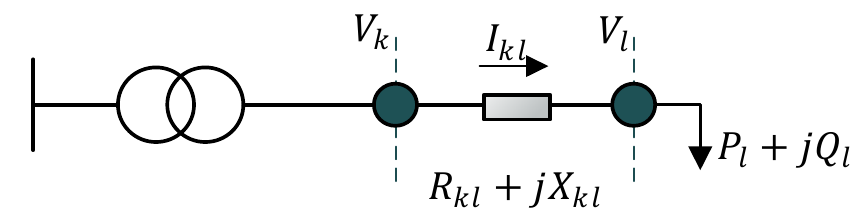
Figure 3. Single line diagram (SLD) of a radial system with two nodes. The steps of the algorithm used for identifying the nominee locations for the integra- tion of DGs are shown in Figure 4. Initially, the power flow analysis is conducted and | (cid:2870) |𝑉 | (cid:2870) {𝑃 | (cid:2870) (cid:3419)𝑃 (cid:3039)(cid:2870) + 𝑄 (cid:3039)(cid:2870) (cid:3423) (19) 𝑉𝑆𝐼 = 2|𝑉 | (cid:2870) − |𝑉 | (cid:2872) − 2|𝑉 𝑅 + 𝑄 𝑋 } − |𝑧 the VSI values are calculated. The nominee nodes, which are selected according to the (cid:3039) (cid:3038) (cid:3039) (cid:3039) (cid:3039) (cid:3038)(cid:3039) (cid:3039) (cid:3038)(cid:3039) (cid:3038)(cid:3039) calculated VSI values ( N N -green color nodes), are utilized to produce the sets of sites for the integration and every produced set of sites have different nodes. Finally, the produced nominee node sets are sent to the optimization procedure. In this approach, the capability of selecting multiple locations is enabled compared to other methods that select a single node. Furthermore, this would benefit in alleviating the search space of DG integrating nodes. This procedure is graphically demonstrated in Figure 4.